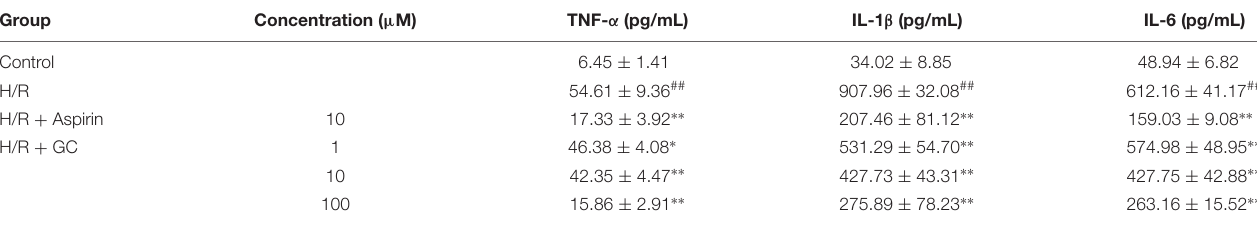
Values were expressed as mean ± SD (n = 8). ## P < 0.01 vs. control group; ∗ P < 0.05, ∗∗ P < 0.01 vs. H/R group.